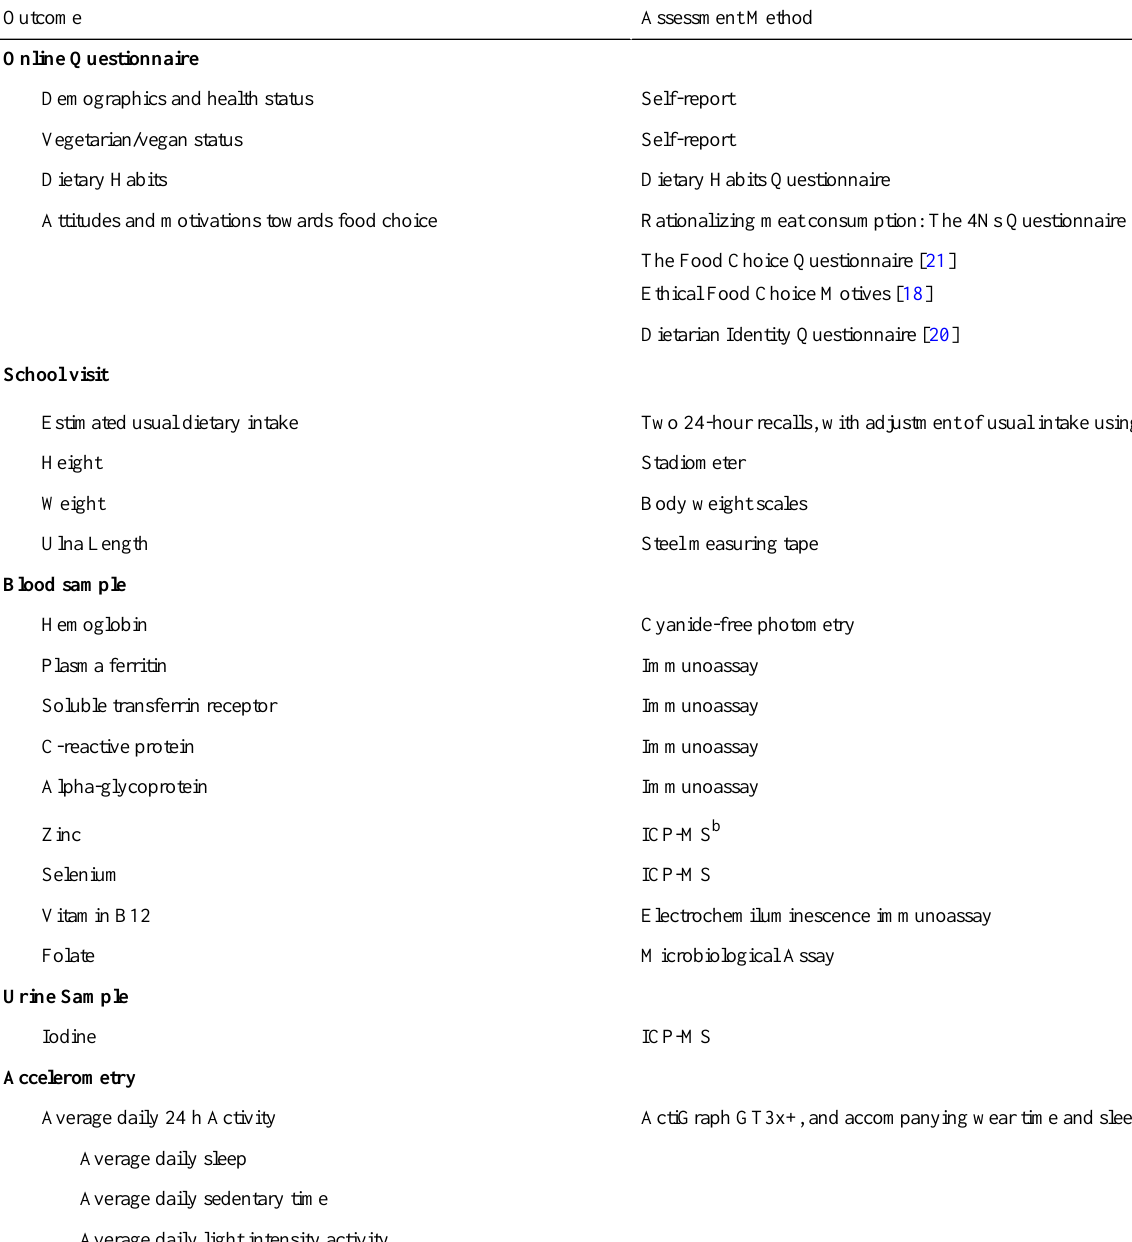
Table 1. Summary of outcome measures to be collected in the SuNDiAL